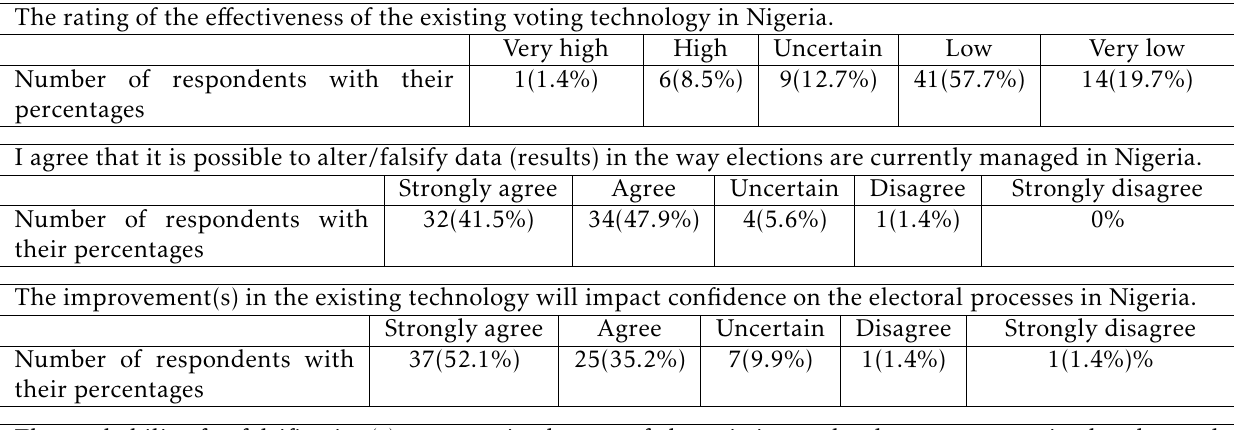
Table 3. Participants’ opinion related to existing voting